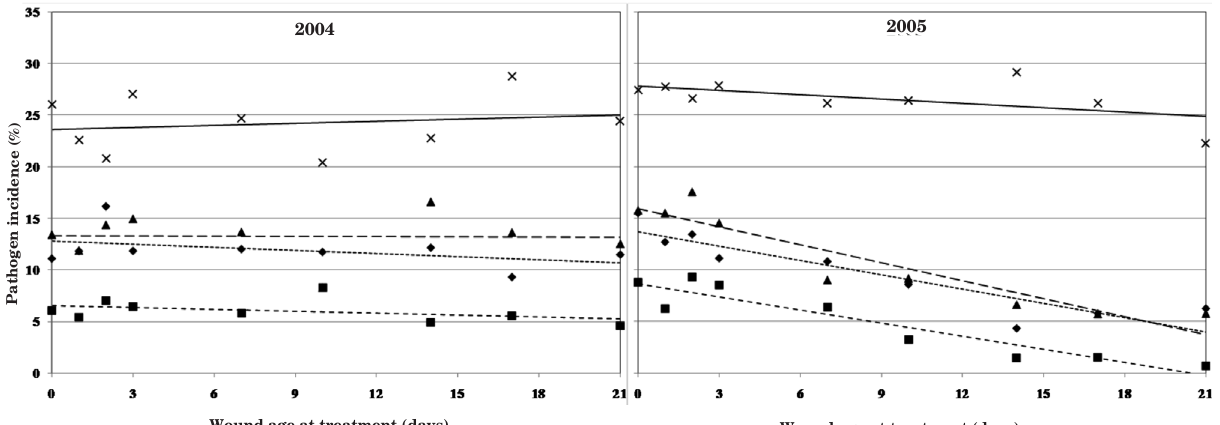
Figure 2. Linear regression lines (Botryosphaeriaceae spp. [ - - - - ]; E. lata [ – – – ]; Pa. chlamydospora [ — — ]; Phomop- sis spp. [ — ]) fitted to the mean pathogen incidence (Botryosphaeriaceae spp. [ t ], E. lata [ n ], Pa. chlamydospora [ ▲ ] and P. viticola [ Ñ ]) over wound age at treatment for the significant year × pruning time × wound age at treatment interaction observed in the 2004 and 2005 pruning